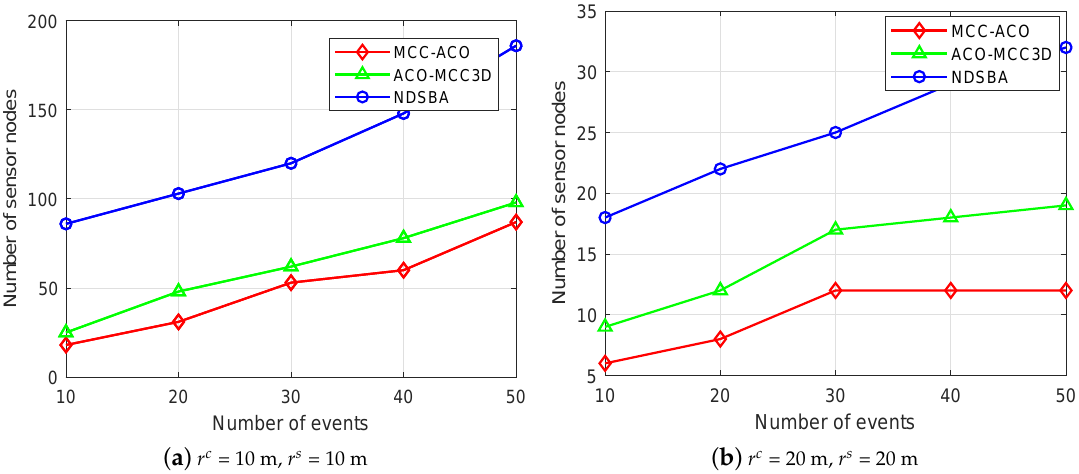
Figure 7. Comparison of the number of deployed nodes for different numbers of